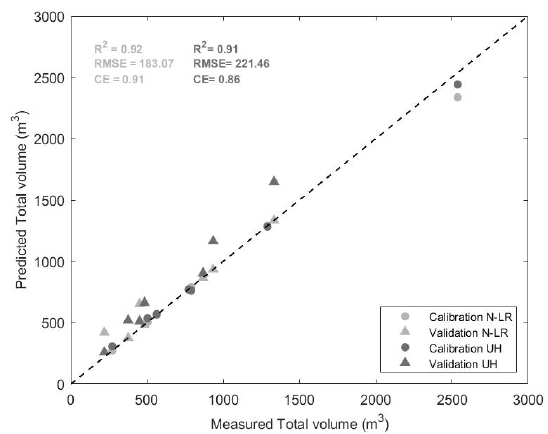
Figure 6. Comparison plot between measured and predicted total volume, for N-LR (light grey) and UH (dark grey) model in either calibration (solid circle) or validation (solid triangle) step.